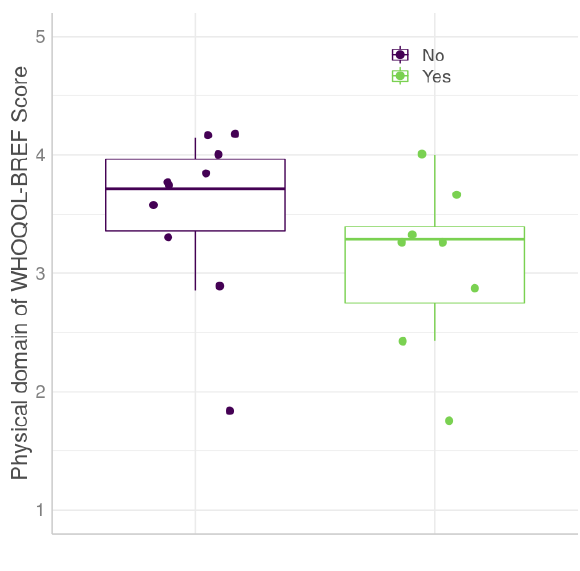
Figure 1. Comparison of World Health Organization Quality of Life-Bref physical domain scores between amputees with phantom pain and whithout panthom pain.